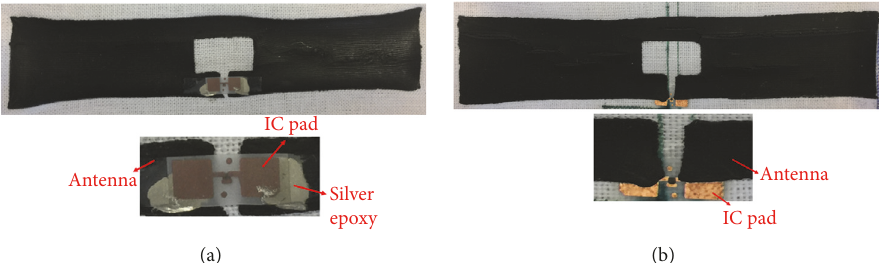
Figure 4: Ready 3D-printed passive UHF RFID tags and magnifications of the antenna-IC interconnections of (a) epoxy-glued joint and (b) printed joint.